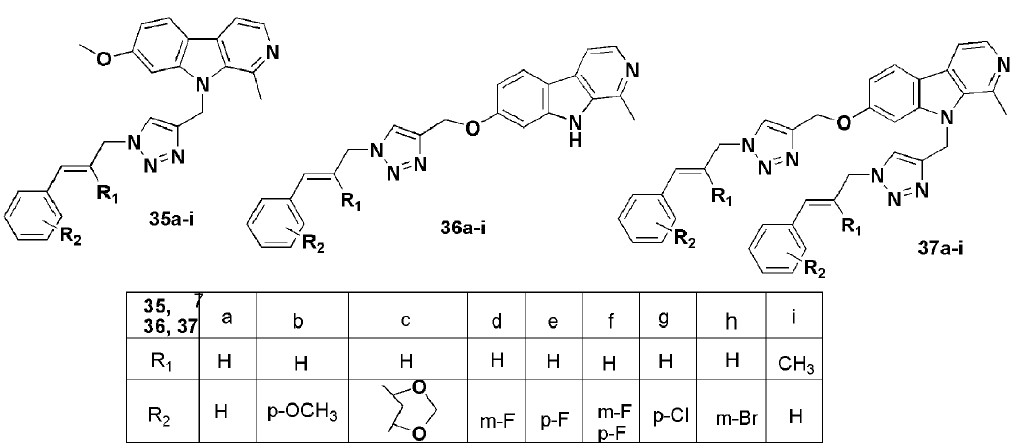
Figure 8. Structures of cinnamic acid-harmine hybrids ( 35–37 ) [33].